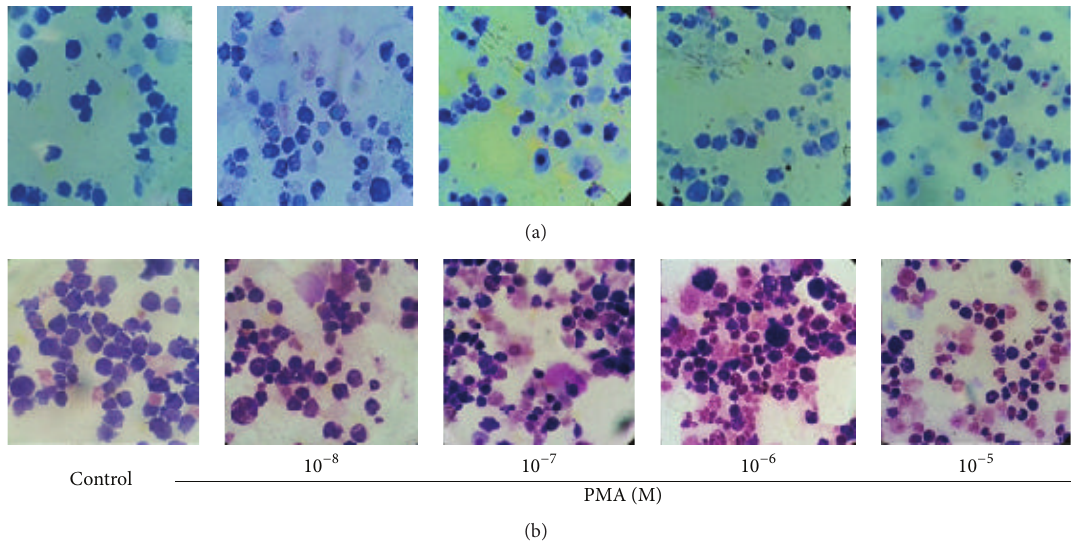
Figure 2: PMA induces macrophage-like differentiation. TF-1a cells were treated with PMA for 72 hours, after which the cells were collected and slides were prepared and then stained following the protocol described in Section 2. (a) Giemsa staining; (b) ( × 1000): methylene blue/eosin staining ( × 1000).